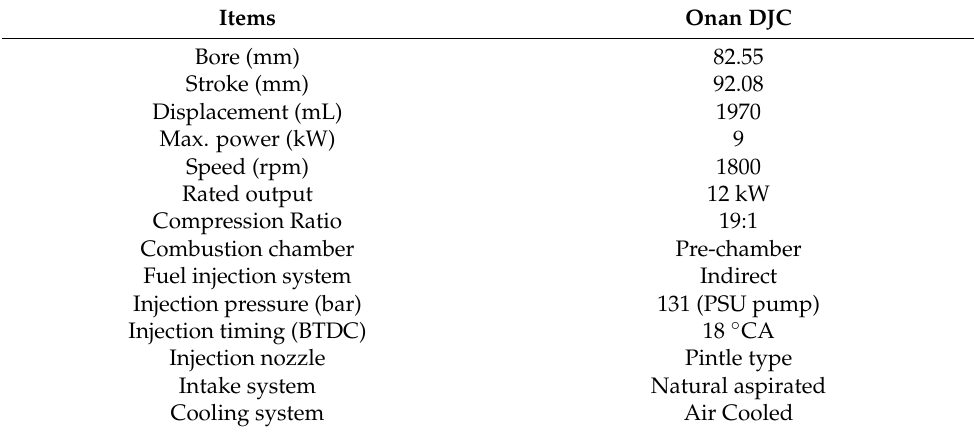
Table 3. Test engine